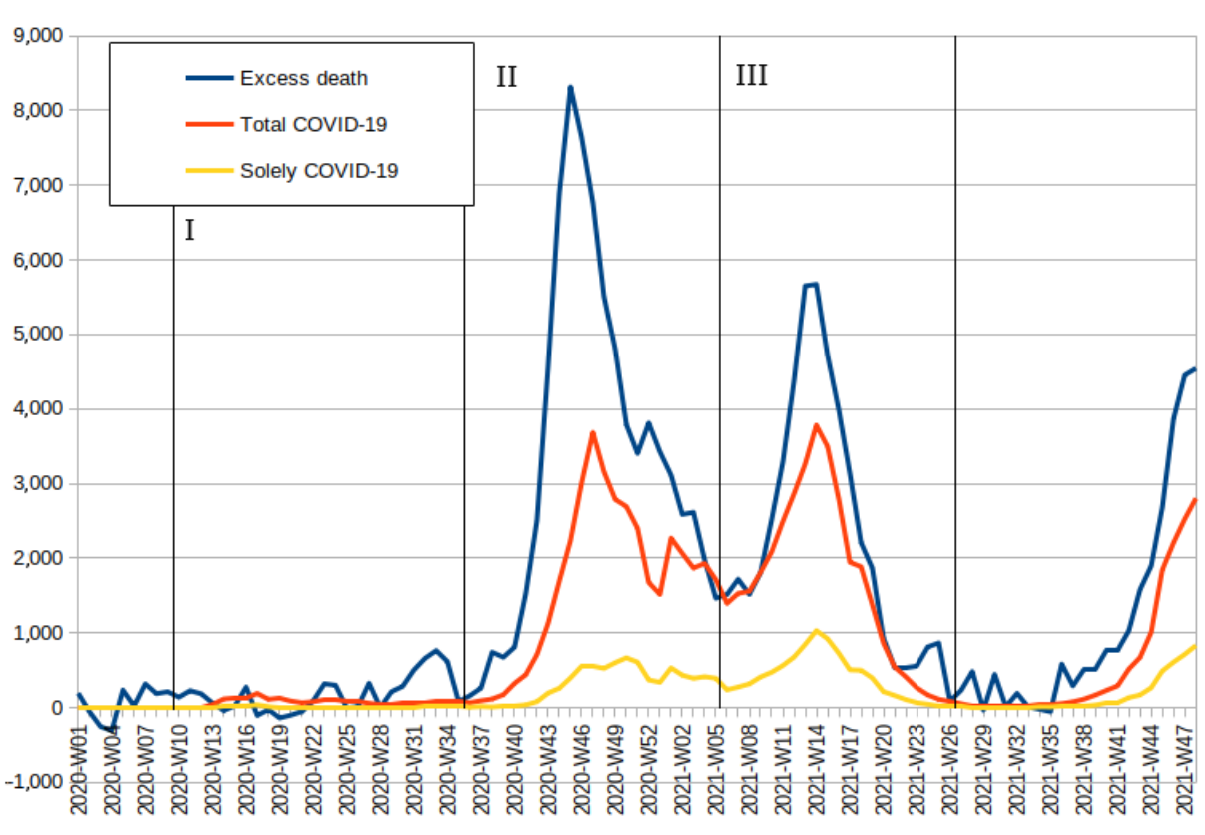
Figure 3. Relation between weekly excess mortality and weekly officially recorded deaths for which COVID-19 was sole or among the listed causes of death, shifted back 4 days to adjust for reporting delay. Data source: Statistics Poland, Polish Chief Sanitary Inspector. Table 1. Comparison of excess mortality, COVID-19 deaths calculated on the basis of our model, and officially reported COVID-19 deaths by demographic groups. Data source—officially reported deaths: Statistics Poland, Polish Chief Sanitary Inspector, inferred deaths: own